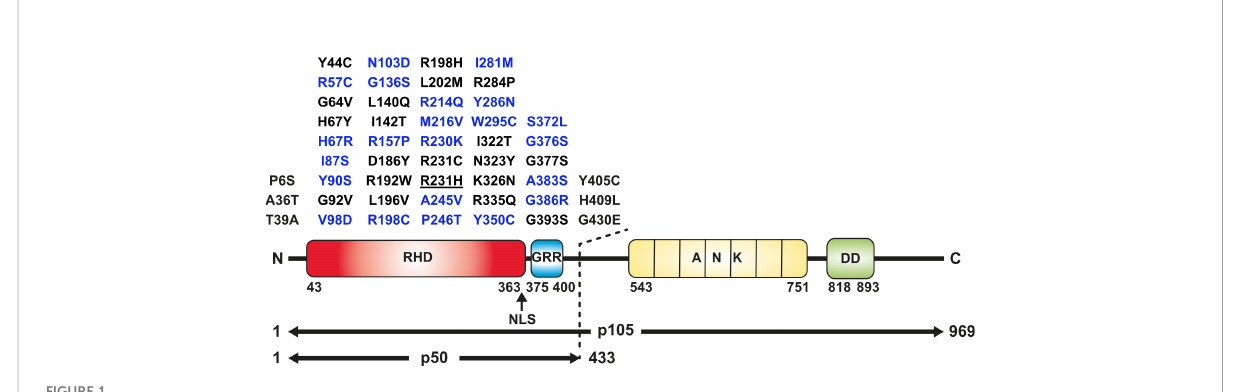
FIGURE 1 Missense variants analyzed in this study and domain structure of p105/p50 (Upper panel) Amino acid changes localizing to the N-terminal half of p105 affect both the precursor and the mature p50. Blue, variants tested in p105 and p50; black, variants tested in p50 only. The panel comprises all p50 variants enrolled in the Tuijnenburg and Lorenzini studies, except R231H (underlined). The deleterious variant Y350C has previously been described (23) and was included as a prototypical control. (Lower panel) The protein domain structure of the p105 precursor (long horizontal arrow) with the Rel-homology domain (RHD; red), glycine-rich region (GRR; blue), Ankyrin-repeat domain (ANK; yellow) and death domain (DD; green). Removal of the C-terminal half by limited proteolysis generates the mature transcription factor subunit p50 (short horizontal arrow). Numbers denominate amino acid positions. The position of the nuclear localization sequence (NLS) is indicated by an